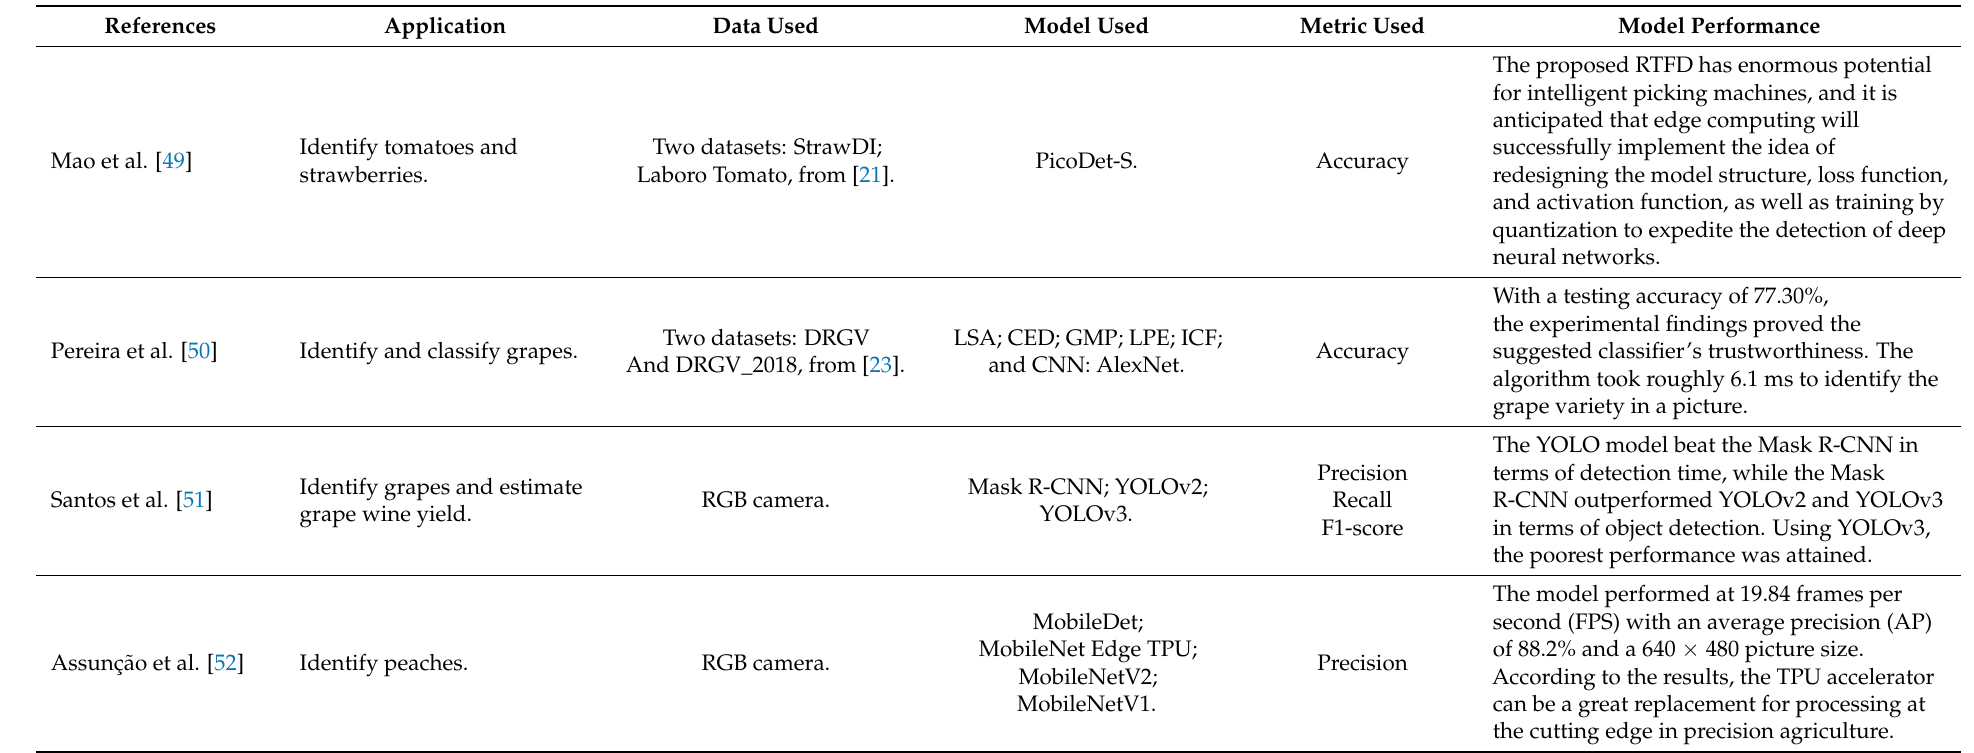
Table 6. Feature descriptions of publications in the field of “Fruit